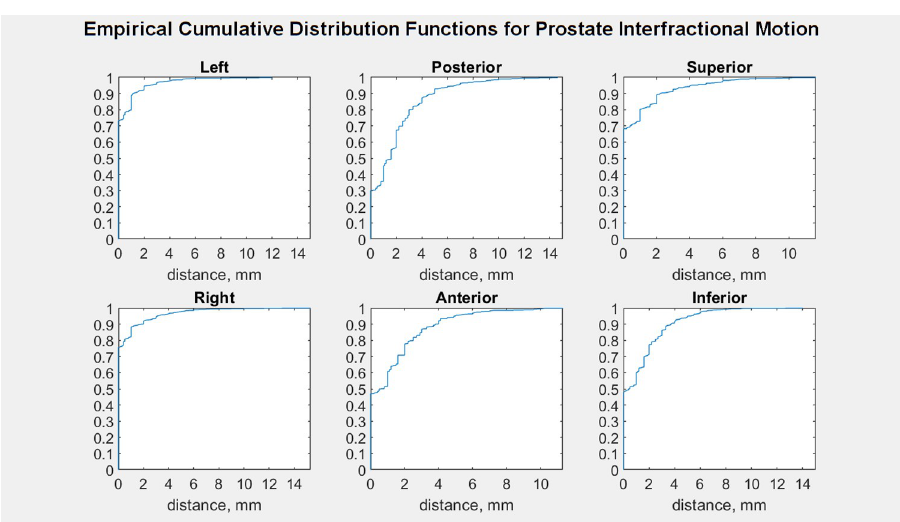
Fig 5. Empirical cumulative distribution function of prostate interfractional displacement. Distance from the planning position per direction.